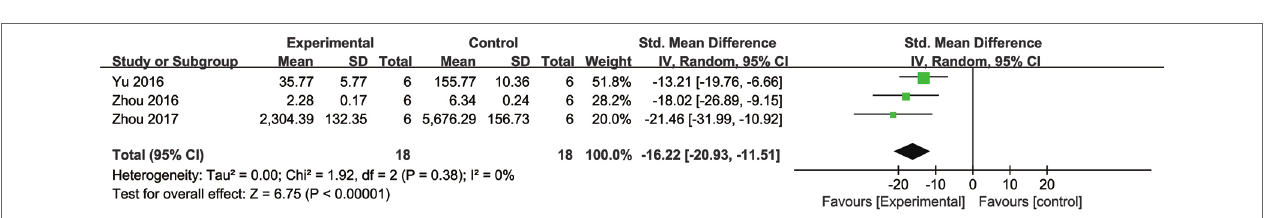
Frontiers in Pharmacology |